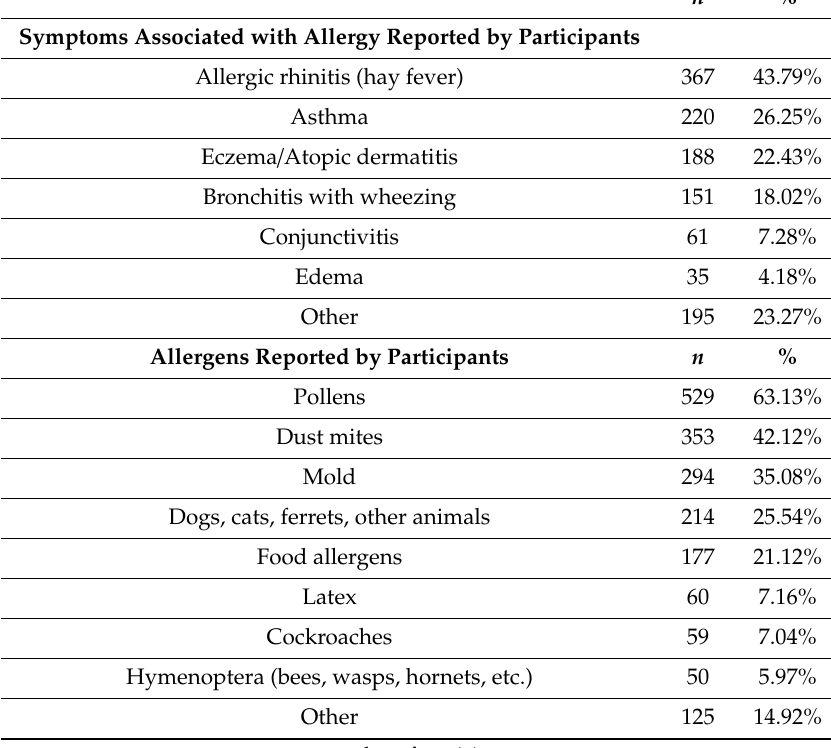
Table 3. Symptoms and allergens related by the allergic population.